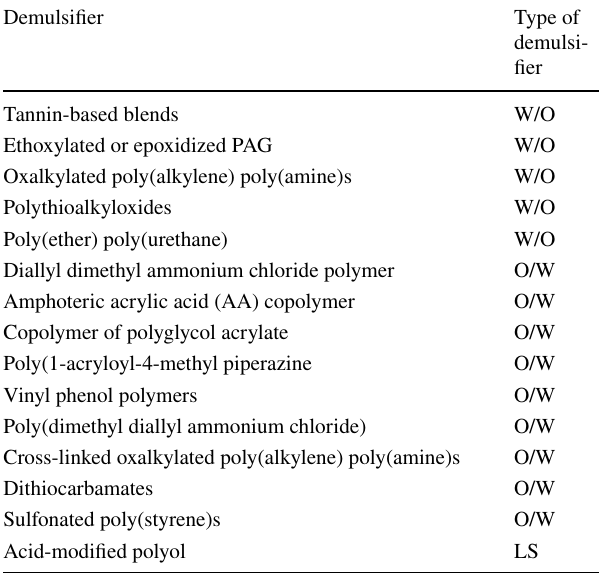
LS liquid–solid separation, O/W oil-in-water use, W/O water-in-oil